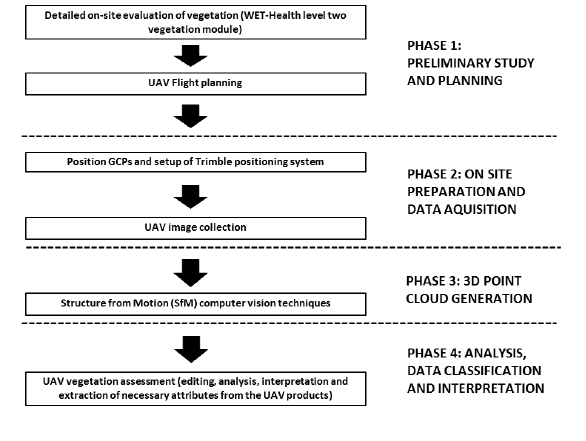
Figure 2. Flow diagram of